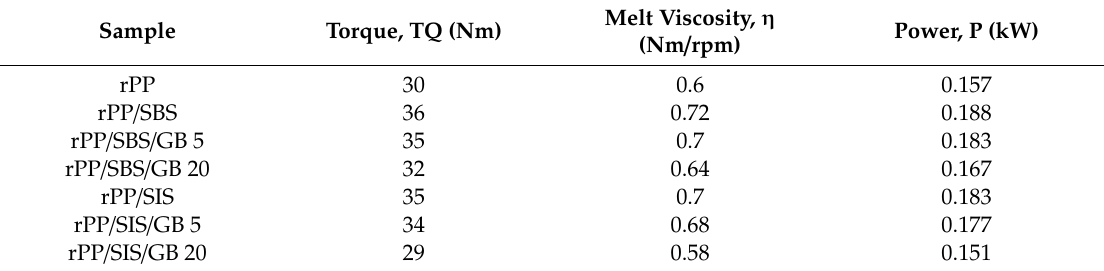
Table 3. Final torque (TQ), melt viscosity ( η ), and power consumption (P) registered at processing of post-consumer rPP and its composites at 180 ◦ C and 50